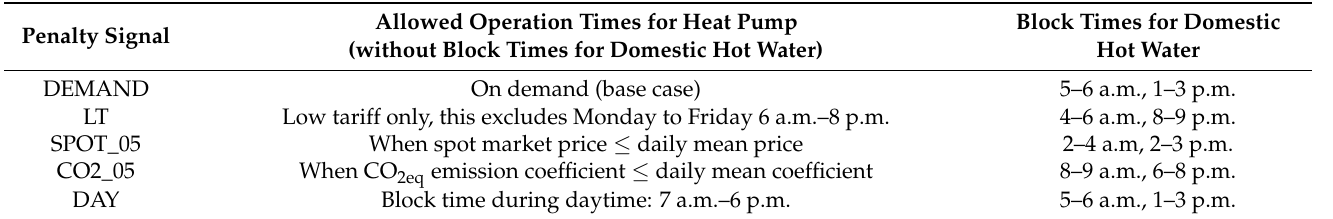
Table 4. Investigated penalty signals for heat pump control [44].